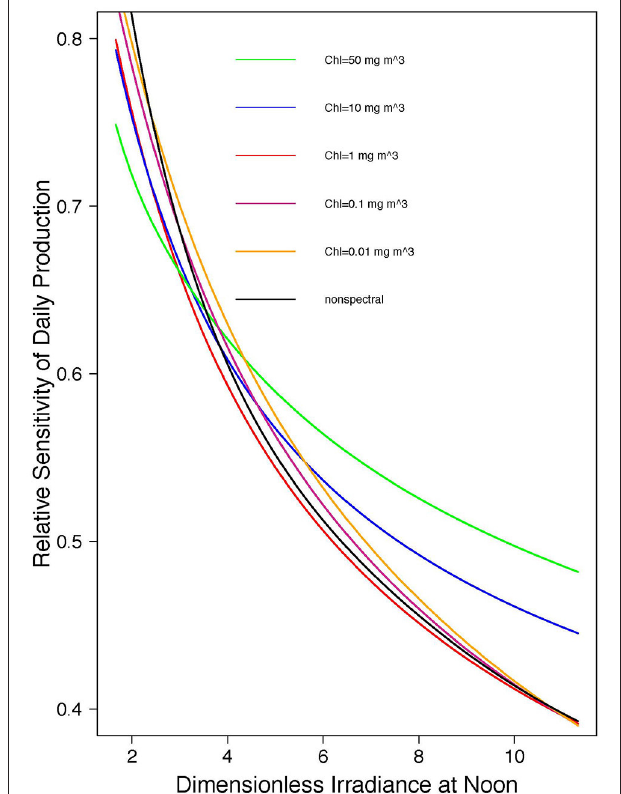
), non-spectral solution, ∗ FIGURE 2 | Relative sensitivity of daily, watercolumn primary production ( P Z , T ) to changes in dimensionless irradiance at noon ( I m numerical integration for different chlorophyll concentrations. Non-spectral result also shown, for